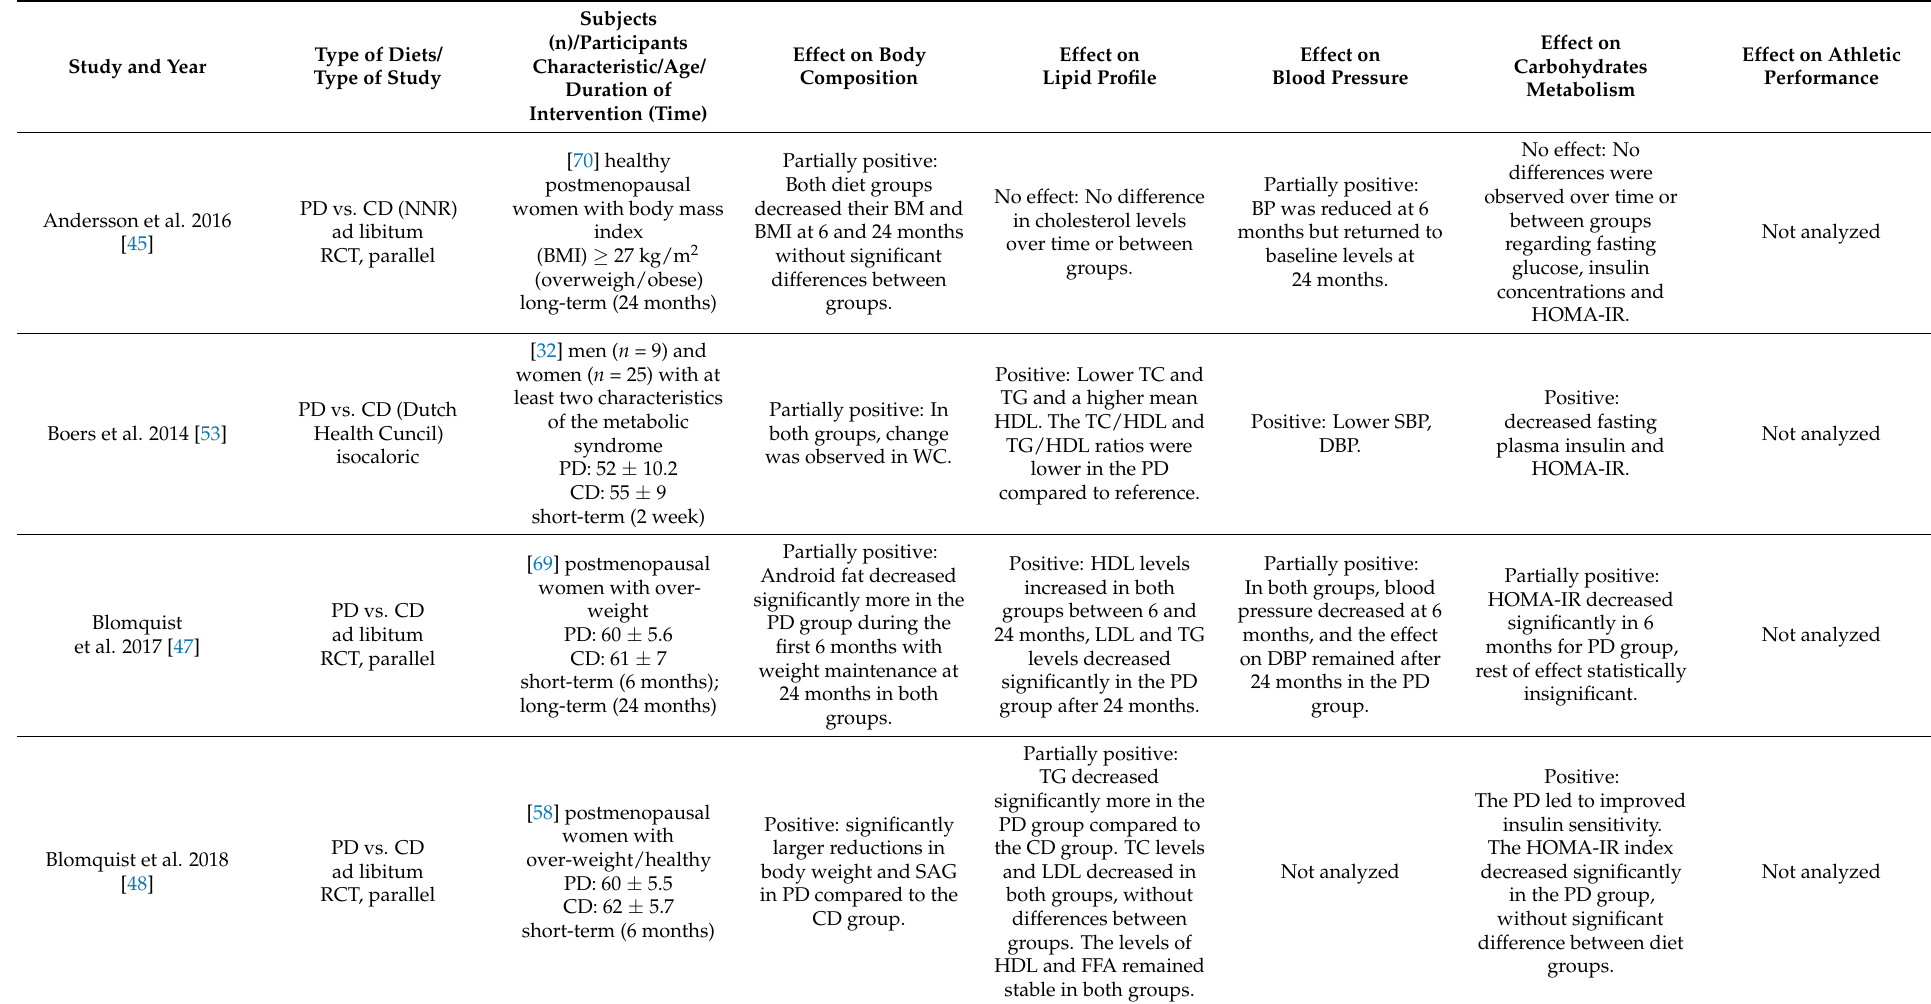
Table 1. Articles included in the meta-analyses according to the author, the year of publications, the type of study, the characteristics of the populations undergoing interventions, and evaluated